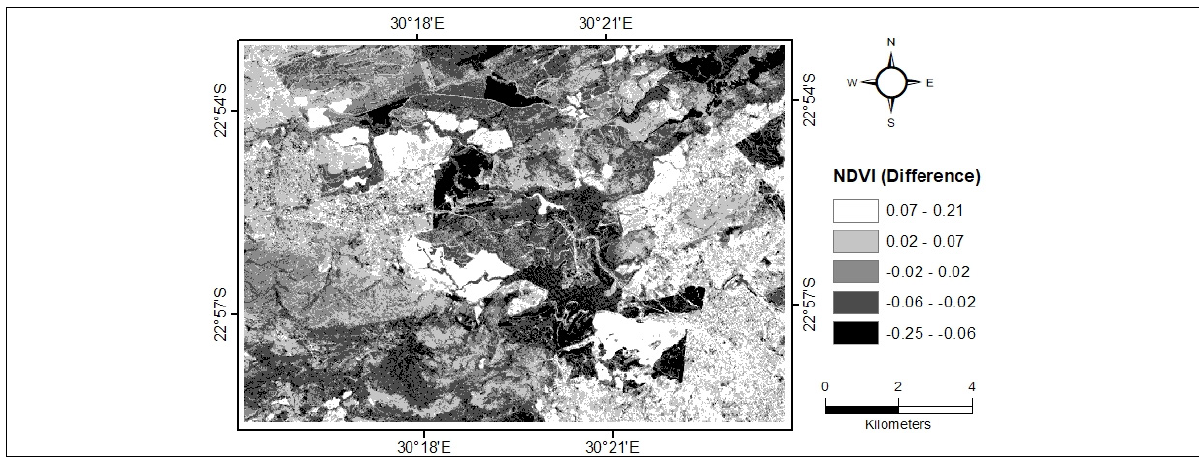
Figure 8: The Normalised Difference Vegetation Index (NDVI) difference image of the time series